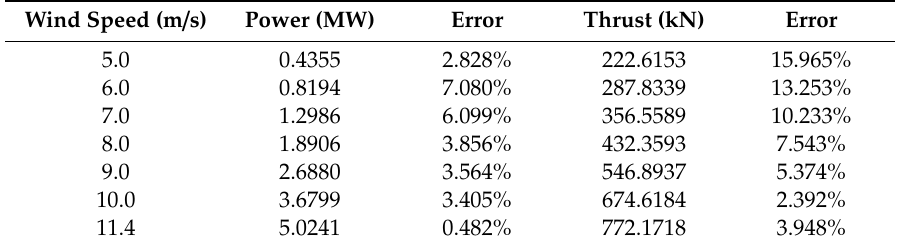
Table 7. Comparisons of the power and the thrust relative error between elastic actuator line model (EALM) and NREL’s FAST code at different wind speeds.